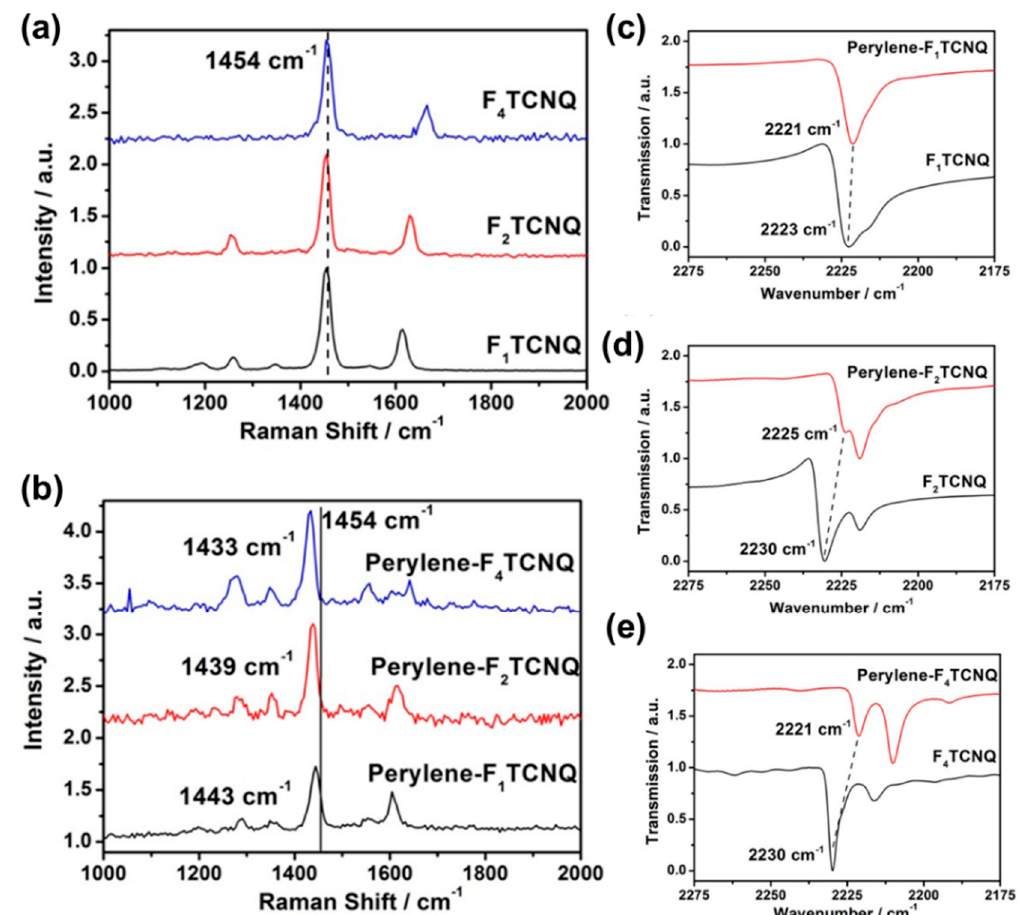
Figure 7. Infrared (IR) and Raman spectra of perylene-F 1 TCNQ, perylene-F 2 TCNQ, and perylene-F 4 TCNQ: ( a ) Raman spectra of pristine F 1 TCNQ, F 2 TCNQ, and F 4 TCNQ; ( b ) Raman spectra of perylene-F 1 TCNQ,